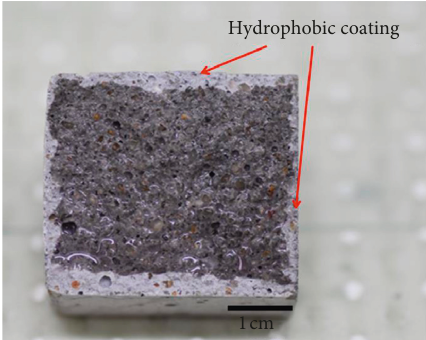
Figure 8: Photograph of the hydrophobic coating’s thickness.